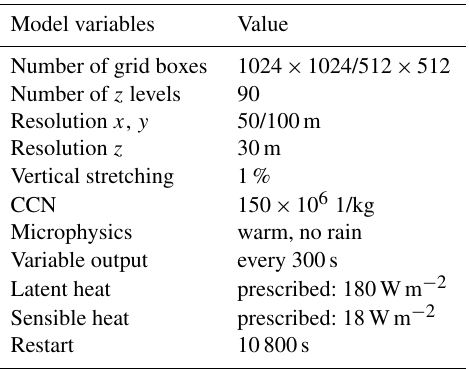
Table 2. Model input for shallow cumulus cloud field